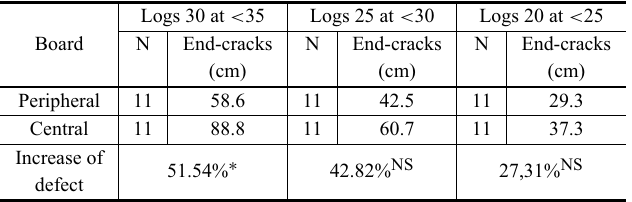
tábuas mensuradas. Concluiu-se que: (1) o modelo estatís- tico sigmoidal logístico explica a variação da temperatura